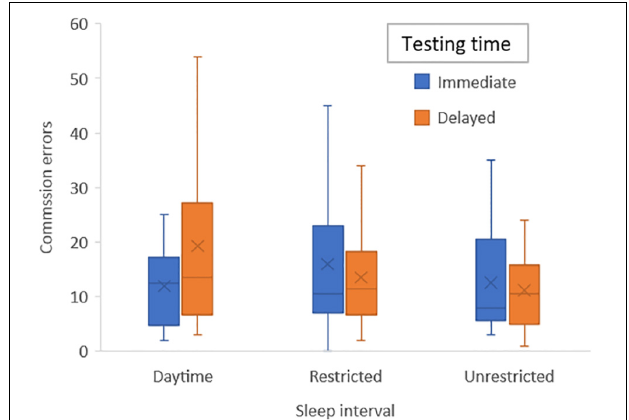
FIGURE 3 | Bar graph of mean number of emotion commission errors for each sleep condition (daytime, unrestricted sleep, and restricted sleep) and for immediate and delayed testing.